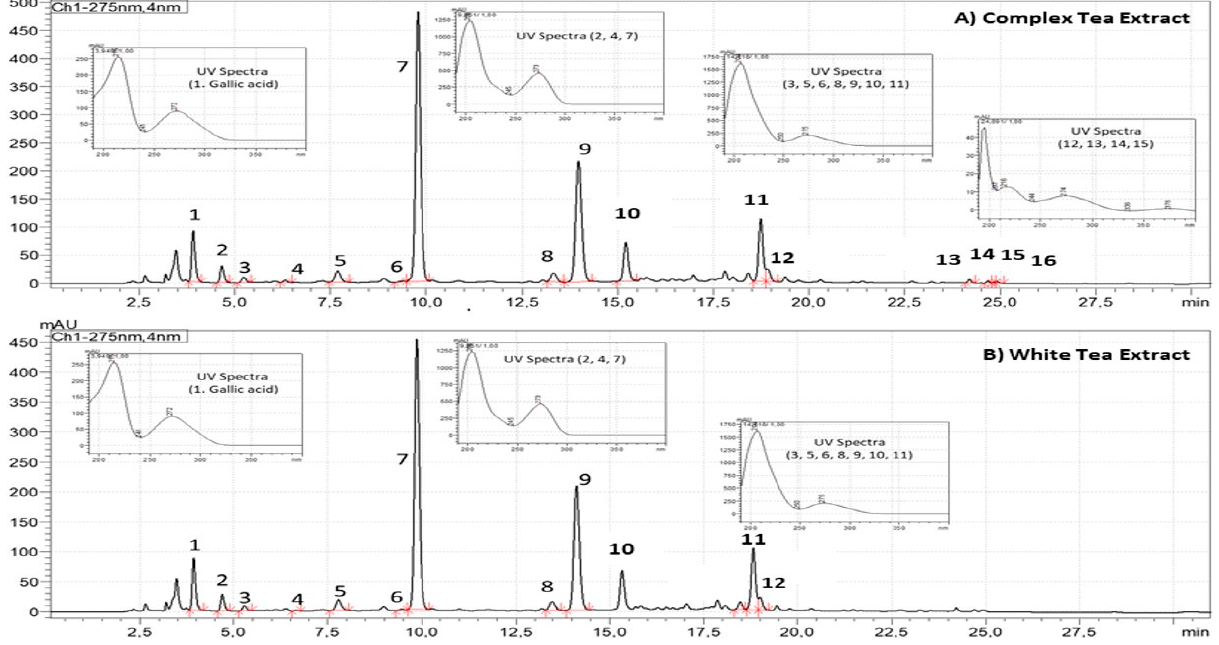
Figure 1. Chromatographic profiles of ADM ® Complex Tea ( A ) and White Tea ( B ) Powdered Extracts standardized to flavan-3-ols (3. Gallocatechin, 5. Epigallocatechin, 6. Catechin, 8. Epicatechin,